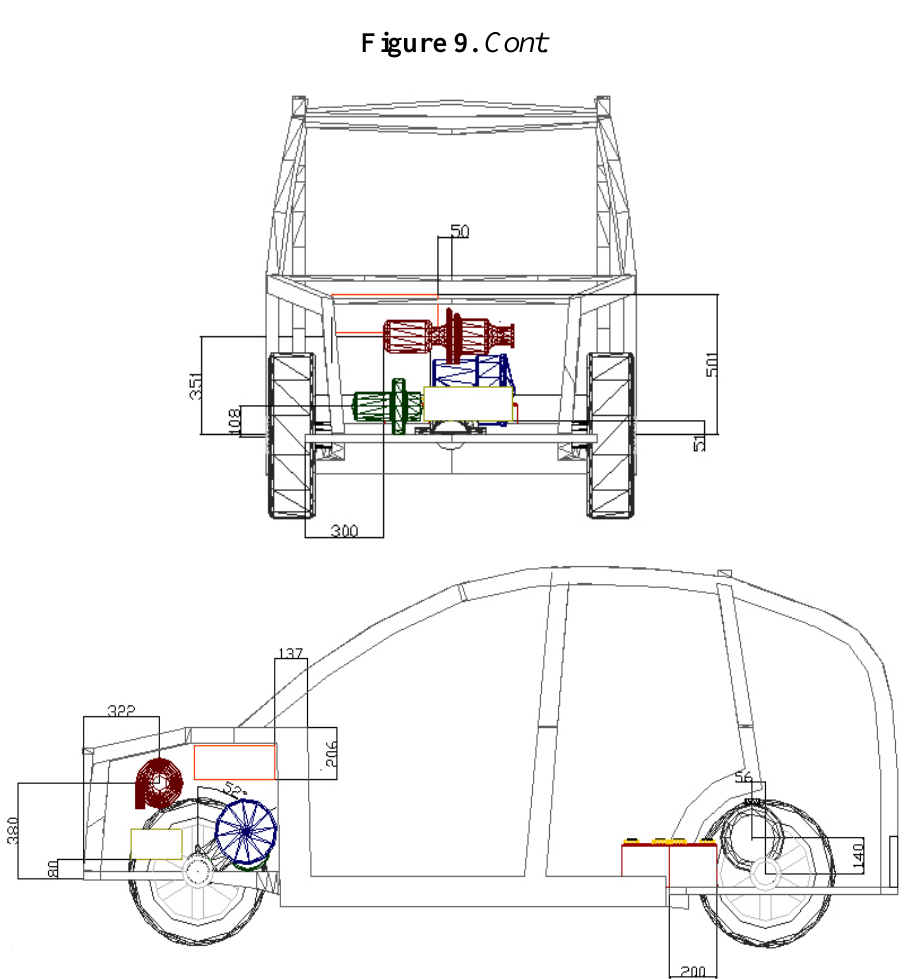
Figure 10. Weight distribution in the LETHE™ City Car configuration.